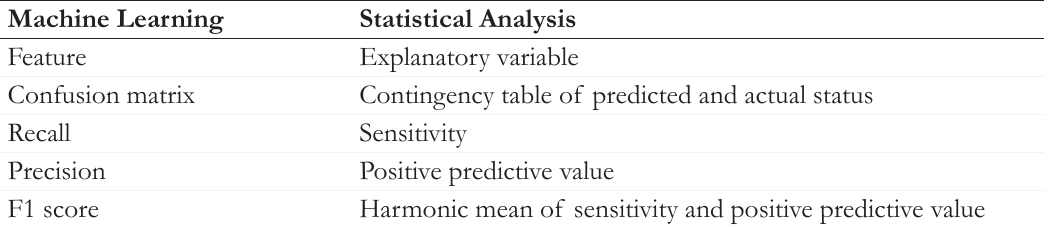
Table 1. Terminology Used in Machine Learning and Statistical Analysis